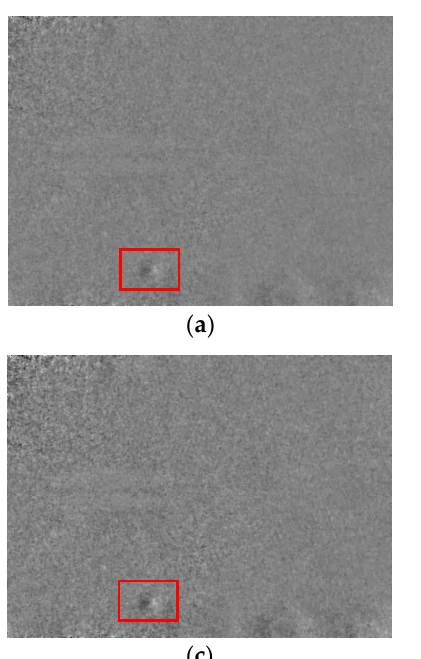
( c ) Figure 4. Visualization of different grid sizes: ( a ) Large scale (32 × 32), ( b ) Medium scale (16 × 16), and ( c ) Small scale (8 × 8). 2.3. Framework: Modify the YOLOv3 SPP Architecture The YOLOv3 architecture [8] is mainly divided into four sections: the Input terminal, Backbone, Neck and Prediction, as shown in Figure 5. The functions of each section are given below, 1.